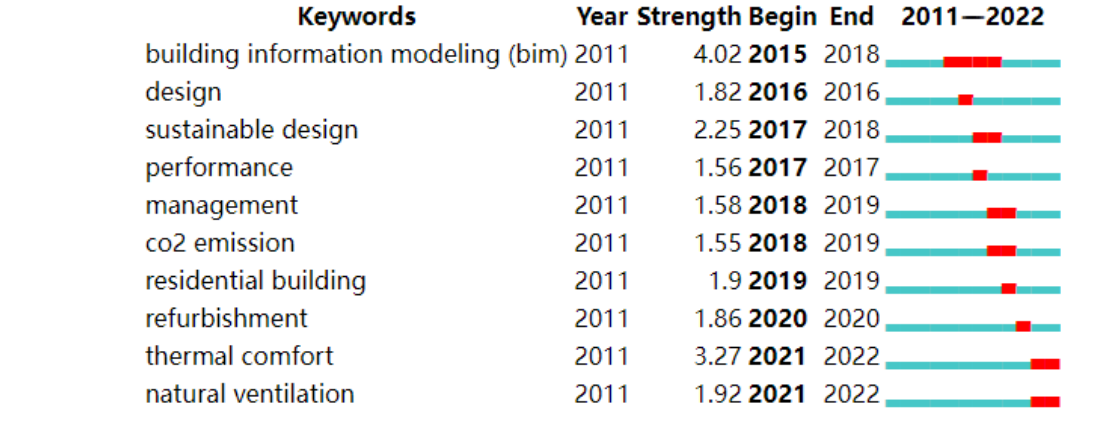
Figure 9. Top 10 words with high burst strengths.